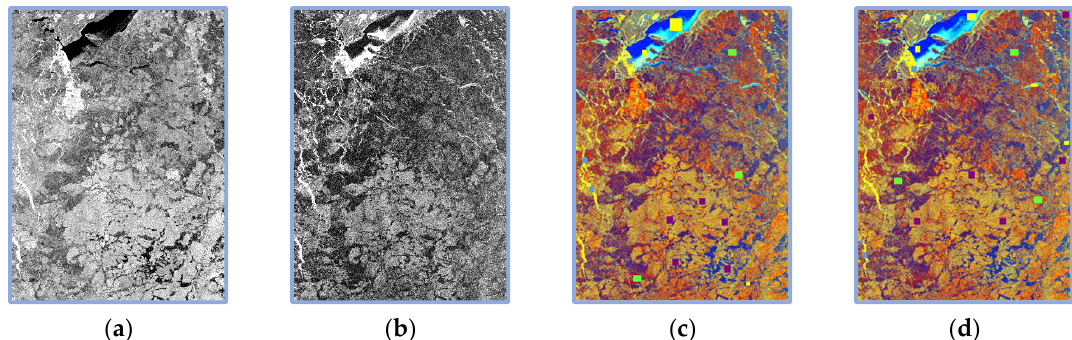
Figure 8. Sentinel-1 image from the Laptev Sea on 6 November 2019. ( a ) Sentinel-1 HH. ( b ) Sentinel-1 HV. ( c ) False color images (R-HH, G-HV, B-HH/HV) with labeled training samples. ( d ) False color images (R-HH, G-HV, B-HH/HV) with labeled testing samples. Table 4. Numbers of the training/testing samples and the color codes of sea ice types in Image I.